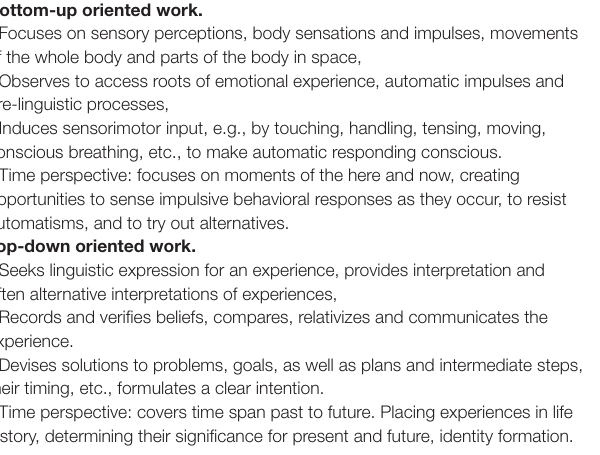
TABLE 3 | Method rules for working in bottom-up and top-down settings (Hauke and Lohr, 2019). Bottom-up oriented work. - Focuses on sensory perceptions, body sensations and impulses,